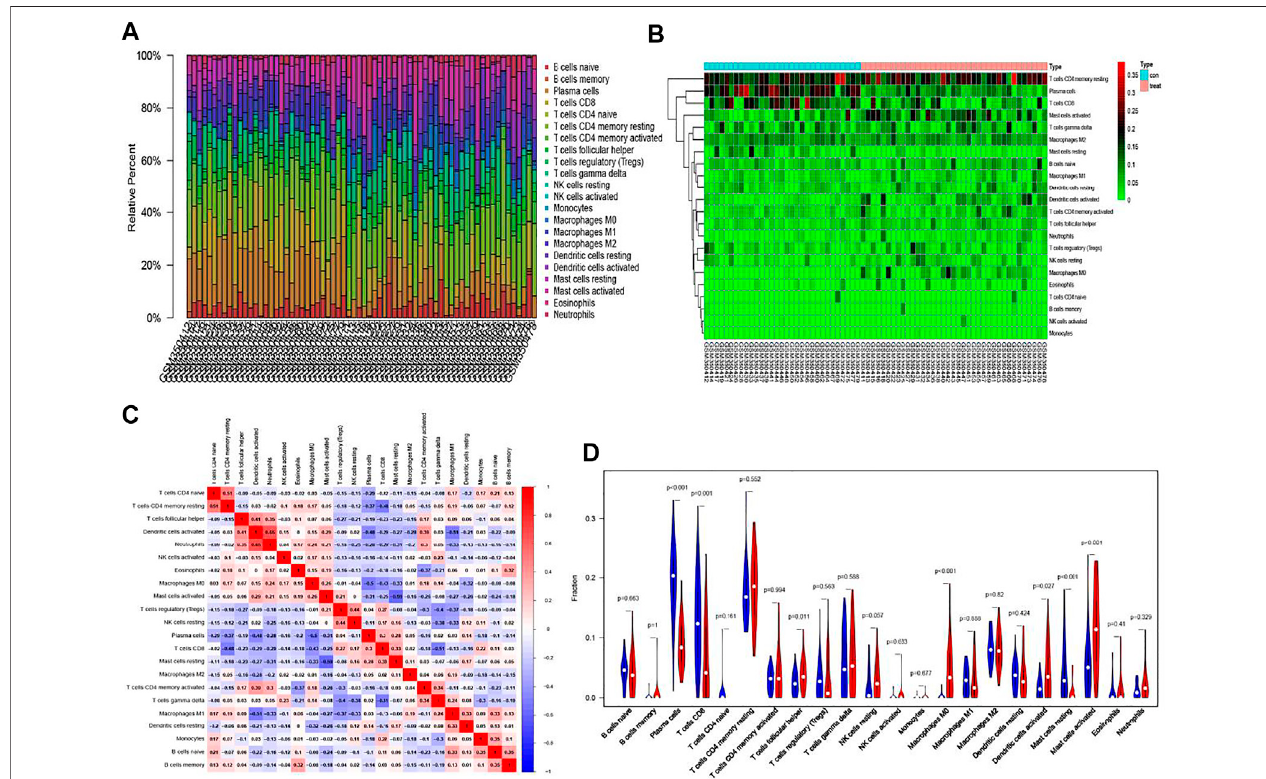
FIGURE 2 | CIBERSORT algorithm for immune in fi ltration analysis of GEO data. (A) Relative percent of 22 kinds of immune cells in GEO. (B) A heat map of the cell in fi ltration data in 69 samples. (C) CorHeatmap of 22 immune cells in normal and tumor tissues. (D) A comparison of normal and tumor tissues. Blue represent normal controls. Red represent tumor